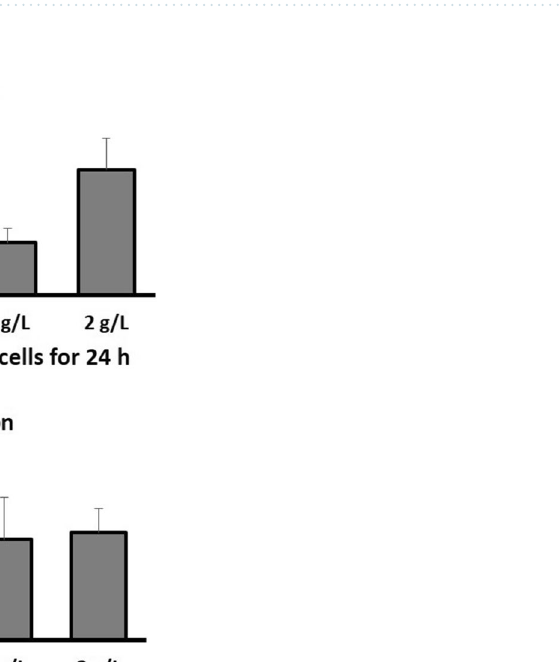
Figure 5. Effect of holo-transferrin on EMT transcription factors. The effect of holo-Tf treatments on the mRNA expression of EMT transcription factor SNAIL ( SNAI1 ) ( a , c ) and SLUG ( SNAI2 ) ( b , d ) for 24 h and 48 h have been shown. Data is presented as mean ± SEM (n = 3–4). * p < = 0.05 and ** p < = 0.03 compared to untreated control (0 g/L).